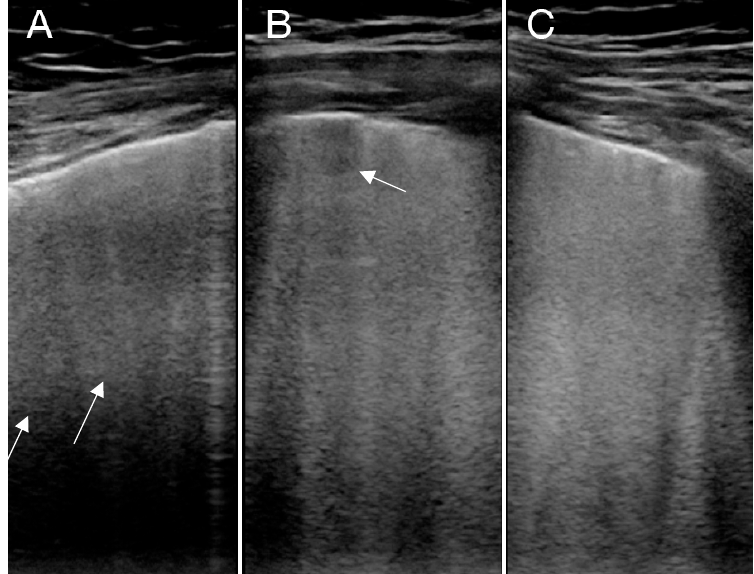
Figure 1. Lung ultrasound (LUS) of three different patients with COVID-19 showing multifocal ( A , B ) (marked with an arrow) and confluent B-lines ( C ). In ( B ), a small subpleural consolidation is also seen (marked with an arrow).